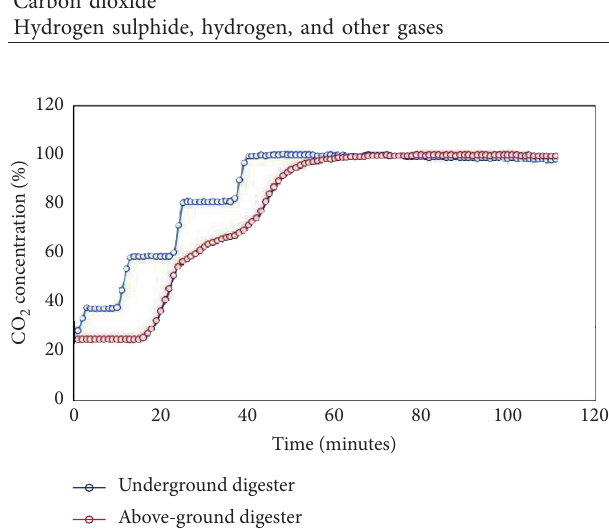
Figure 8: CO 2 concentration in the underground and above- ground digesters showing the stable level for almost an hour under high pressure.